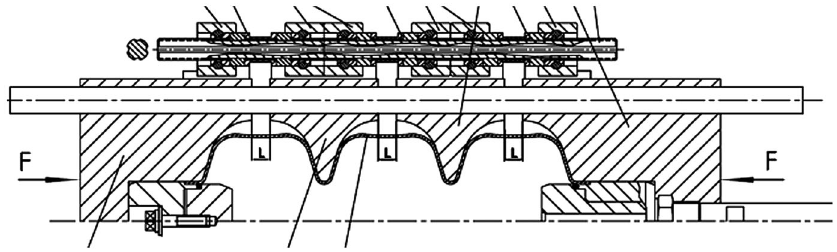
FIG. 17. Shape of the molds for final forming.